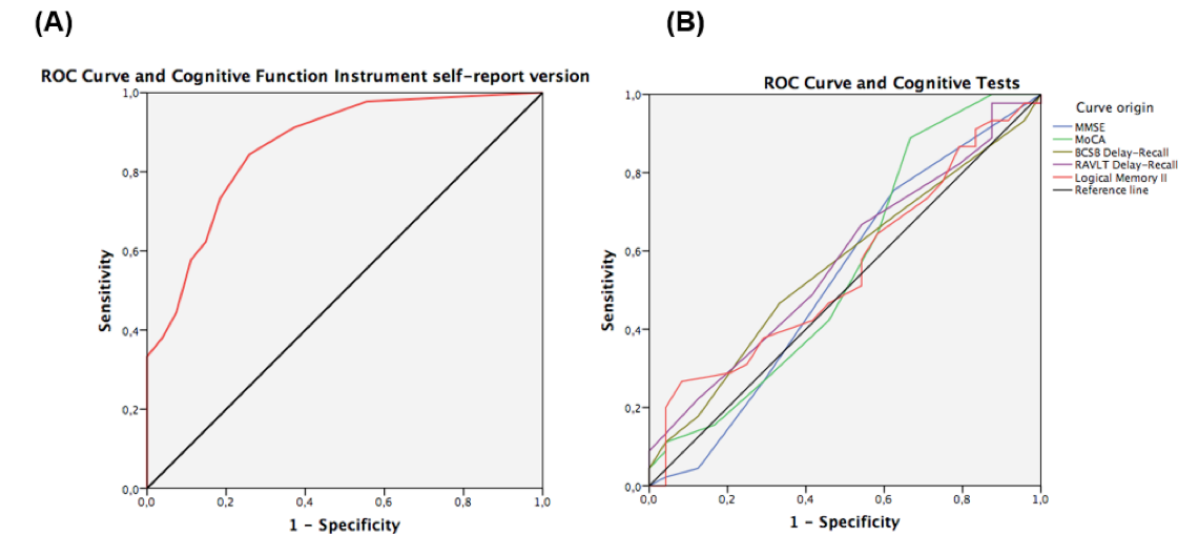
Figure 2. Receiver Operating Characteristic (ROC) curve was used to calculate the area under the curve (AUC) with a 95% confidence interval (95%CI) in a sample with subjective cognitive decline (SCD group) and without decline (control group). (A) Cognitive Function Instrument Receiver Operating Characteristic curve (AUC=0.865 with 95%CI 0.779–0.951, p<0.001). (B) Cognitive tests: Mini Mental State Examination (MMSE; AUC=0.529 with 95%CI 0.377–0.680, p=0.696), Montreal Cognitive Assessment (MoCA; AUC=0.556 with 95%CI 0.402–0.709, p=0.450), Brief Cognitive Screening Battery Delay-Recall (BCSB; AUC=0.562 with 95%CI 0.422–0.701, p=0.402), Rey Auditory Verbal Learning Test Delay-Recall (RAVLT; AUC=0.562 with 95%CI 0.435–0.714, p=0.310), and Logical Memory II (AUC=0.552 with 95%CI 0.411–0.693,